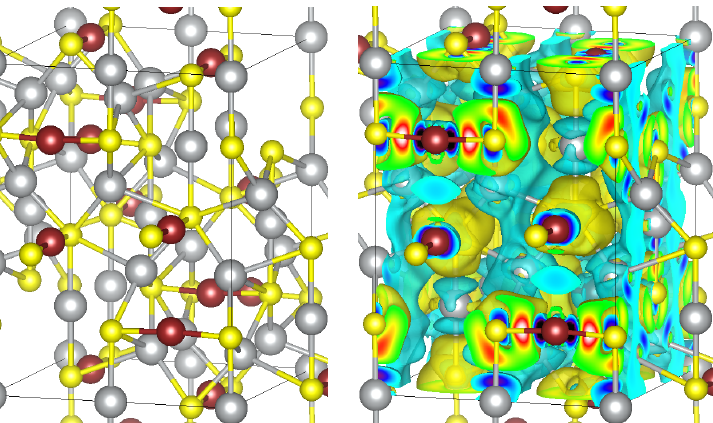
Figure 1. Body-centered tetragonal unit cell of Ag 3 CuS 2 in jalpaite I4 1 /amd structure ( left panel). Ag, Cu and S atoms are depicted using gray, brown and yellow spheres, respectively. Redistribution of electron density ( right panel). The yellow contours correspond to an increase, and the cyan contours correspond to a decrease in the electron density compared to the electron density of atoms placed at the same